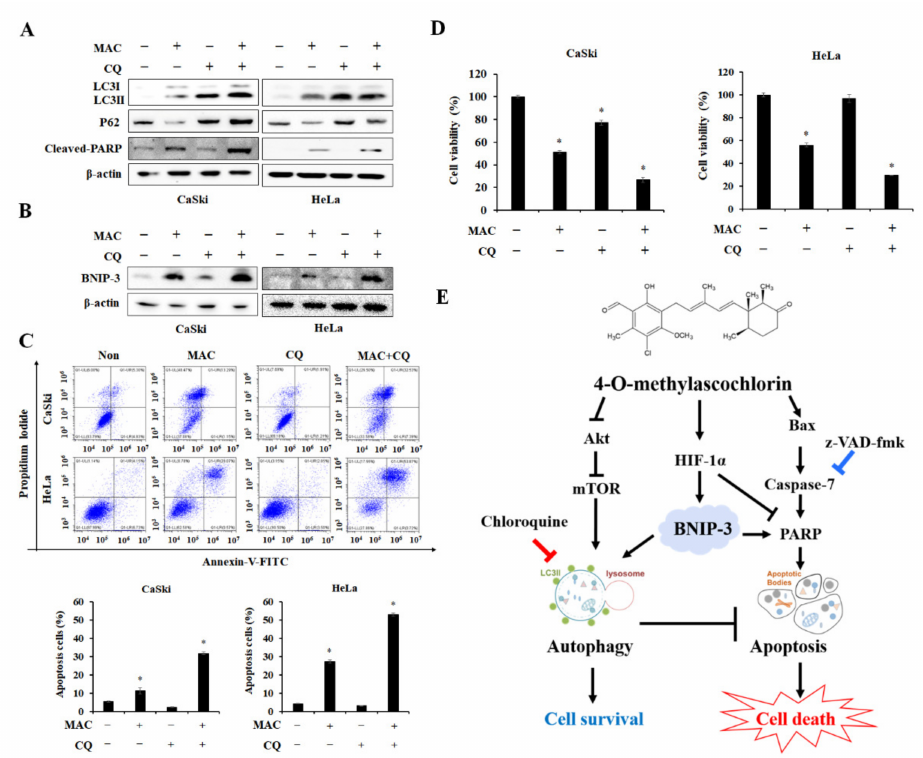
Figure 6. CQ enhances MAC-induced apoptosis in cervical carcinoma cells. ( A ) Cells were treated with MAC (20 µ M) for 24 h in the presence or absence of CQ (50 µ M), Western blotting analysis was used to determine the protein levels of LC3, P62 and cleaved-PARP in cell lysates. ( B ) After the treatment as ( A ) for 12 h, the protein level of BNIP-3 was conducted by Western blot analysis. ( C ) Cells were treated with MAC in the presence or absence of CQ, and double stained Annexin V-FITC/PI. The apoptotic cells were verified by Flow cytometry. ( D ) Cells were incubated with MAC and CQ for 24 h, then cell viability was conducted with WST-8 assay. Data represent the mean ± SD of three independent experiments. * p < 0.05 vs. control. Results were analyzed using one-way ANOVA followed by Bonferroni post hoc test. ( E ) Suggest molecular mechanism by which BNIP-3 expression regulates the balance of MAC-induced autophagy and apoptosis in cervical cancer